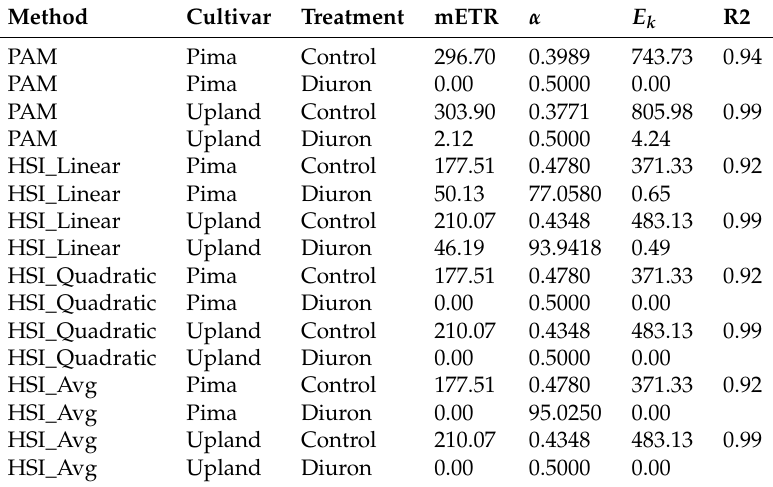
Table 1. Rapid light curves (RLCs) calculated using ETR and PAR values for each